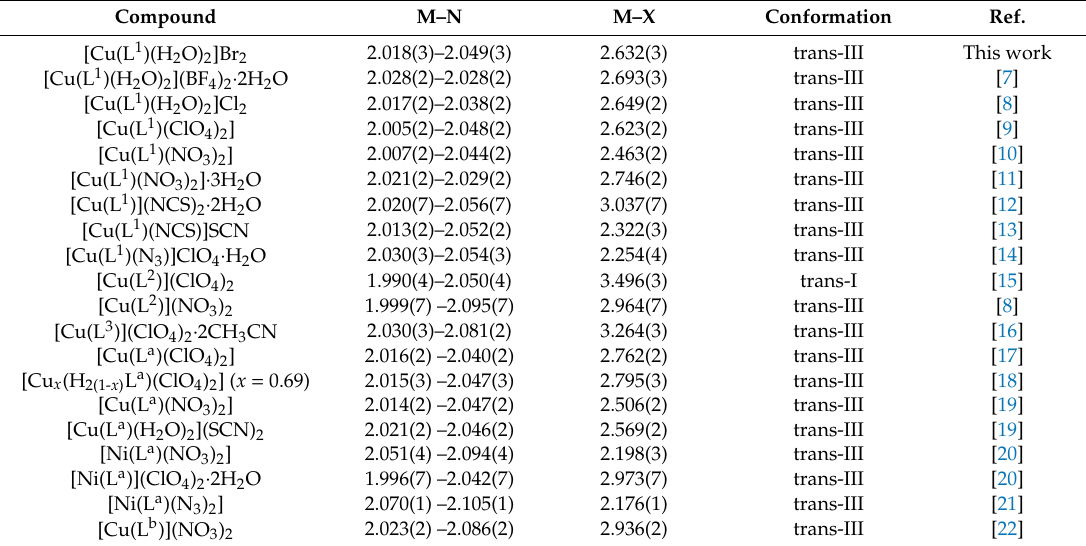
Table 3. Selected bond distances (Å) and conformations of metal complexes with macrocyclic ligands. Compound M–N